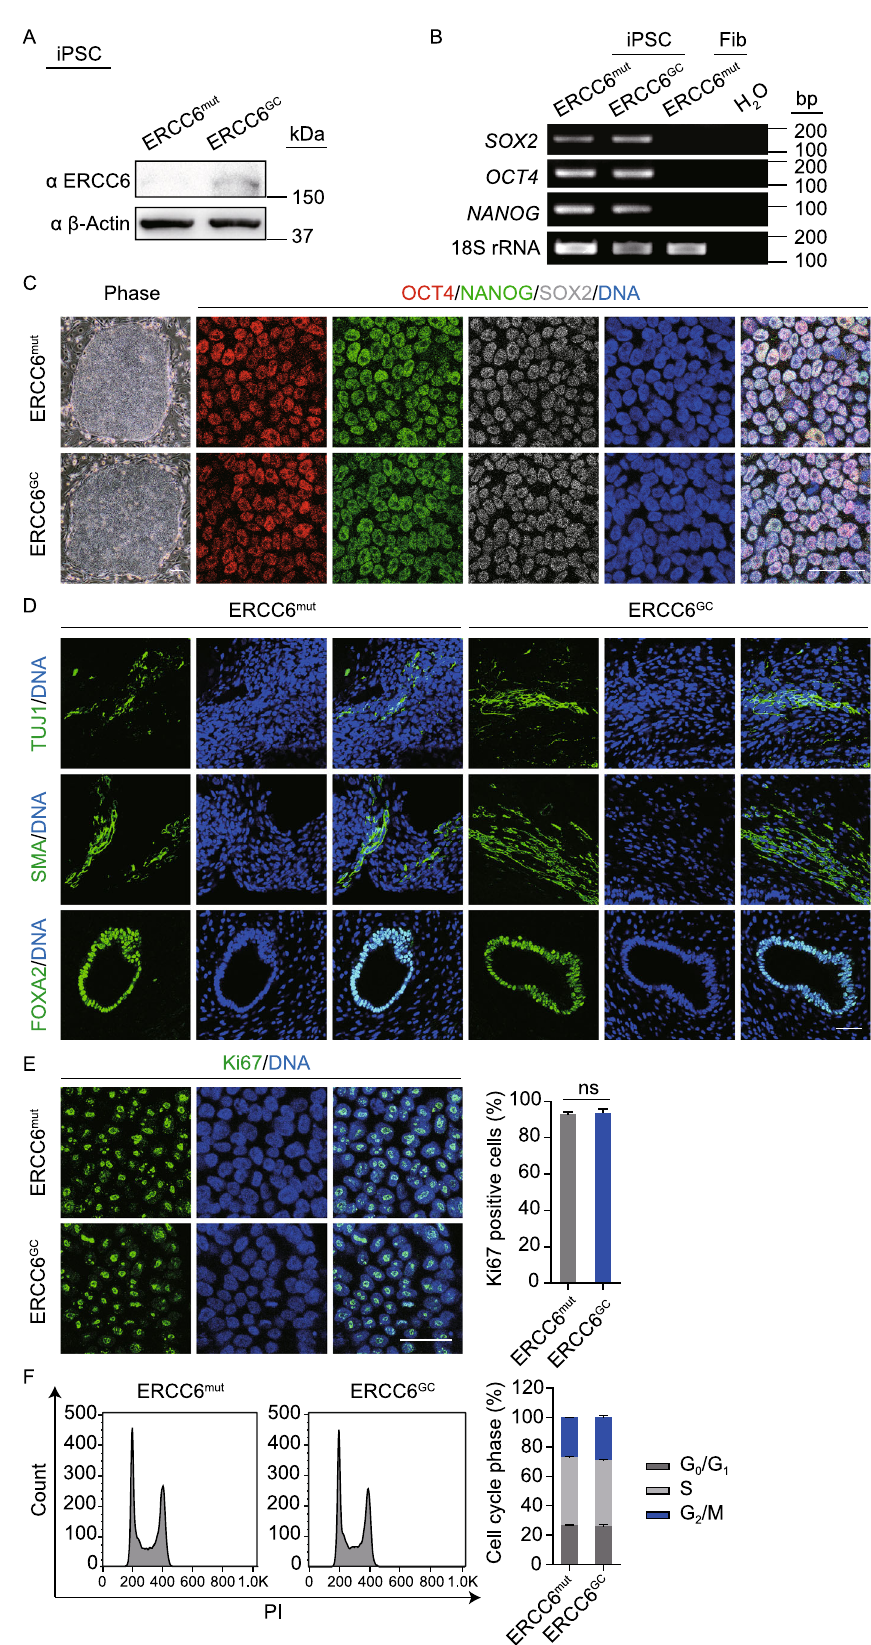
Figure 2. Characteriza- tion of CS-iPSCs and gene-corrected CS-iPSCs. (A) Western blot analysis showing increased protein levels of ERCC6 in GC- iPSCs. β -Actin was used as the loading control. (B) RT-PCR analysis of the pluripotency markers SOX2 , OCT4 , and NANOG in the CS-iPSCs and GC- iPSCs. 18S rRNA was used astheloadingcontrol.(C)Im- munostaining of CS-iPSCs and GC-iPSCs for the pluripotency markers OCT4, NANOG, and SOX2. Nuclei were stained with Hoechst 33342. Scale bar, 50 μ m.